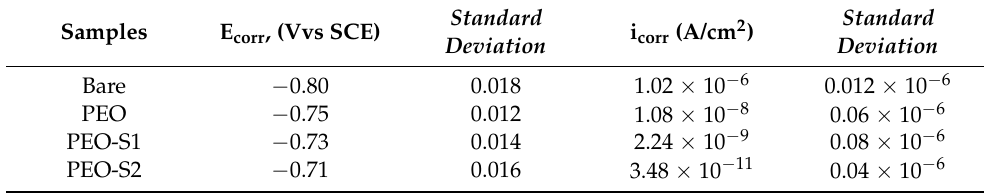
Table 1. The fitted results of the Tafel curves.